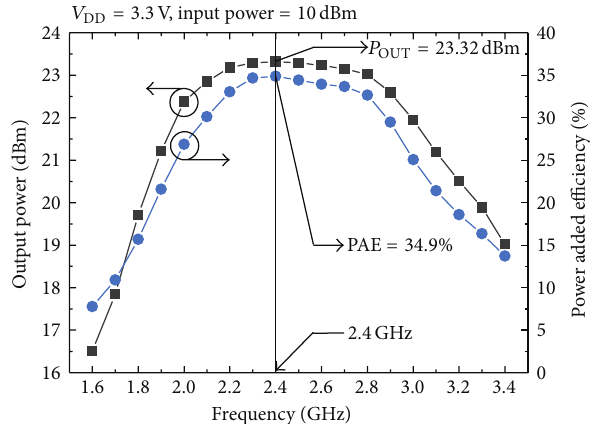
Figure 7: Measured output power and efficiency according to operating frequency.